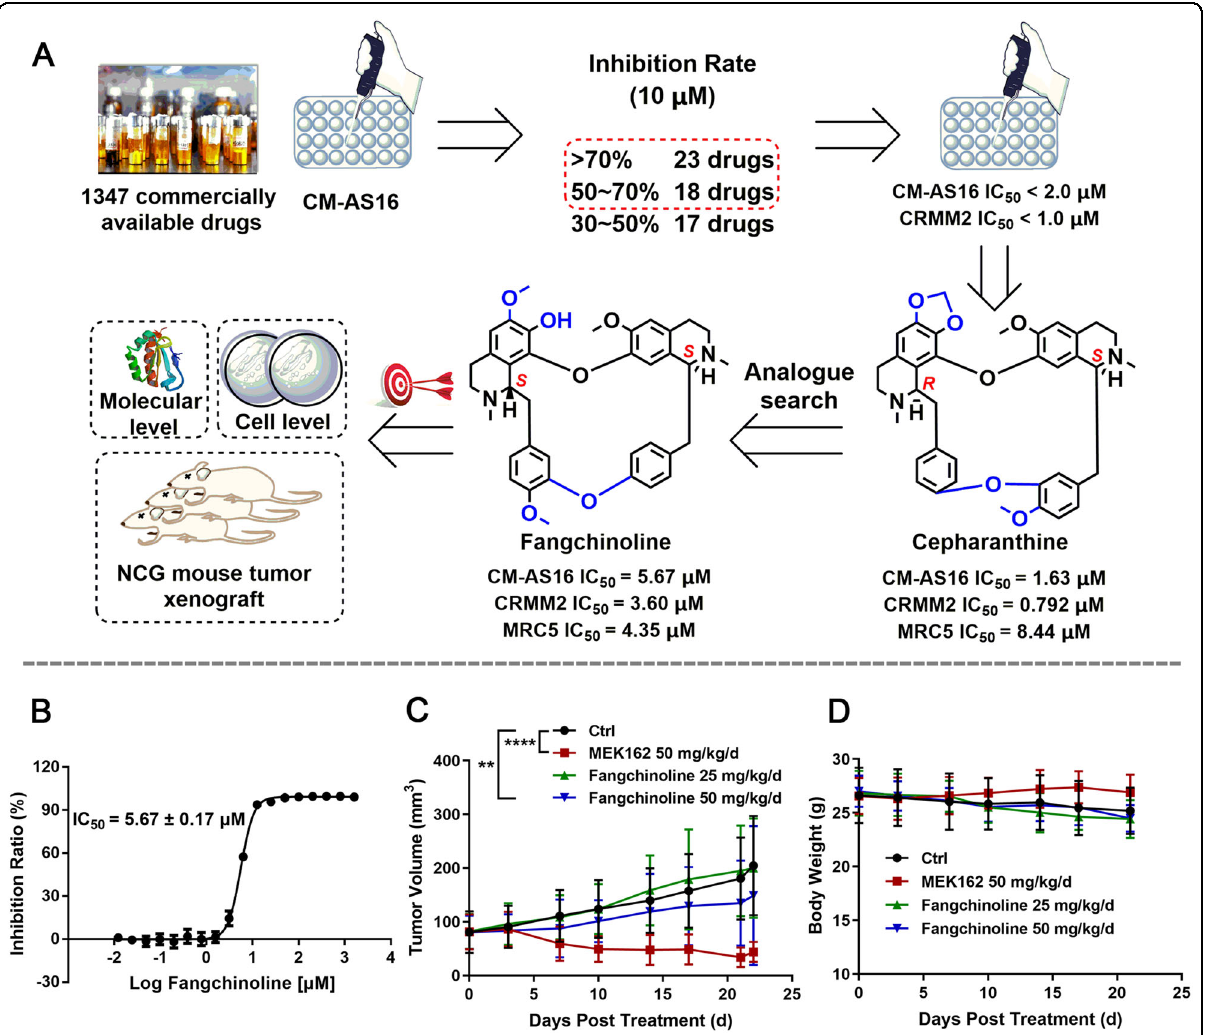
Fig. 1 Therapeutic ef fi cacy of fangchinoline in vitro and in vivo. A Schematic of the phenotypic screening protocol from which fangchinoline was discovered to be a potent inhibitor of CM-AS16 cell proliferation. B Inhibition curve of fangchinoline against CM-AS16 cells based on the CCK-8 assay. The results are shown as the mean ± SD ( n = 3). C Tumour volume of CM-AS16 tumour xenografts in NCG mice. Mice were treated with increasing doses of fangchinoline (0, 25, and 50 mg/kg/d) or MEK162 (50 mg/kg/d) for 22 days ( n = 7). Notably, three mice under 25 mg/kg fangchinoline treatment died before killing. After 22 days, the mice were killed and the tumours were removed and analysed. D Body weight changes in control and drug-treated NCG mice. Data represent the mean ± SD, n = 7 per group. * P < 0.05, ** P < 0.01, **** P < 0.0001, by two- way